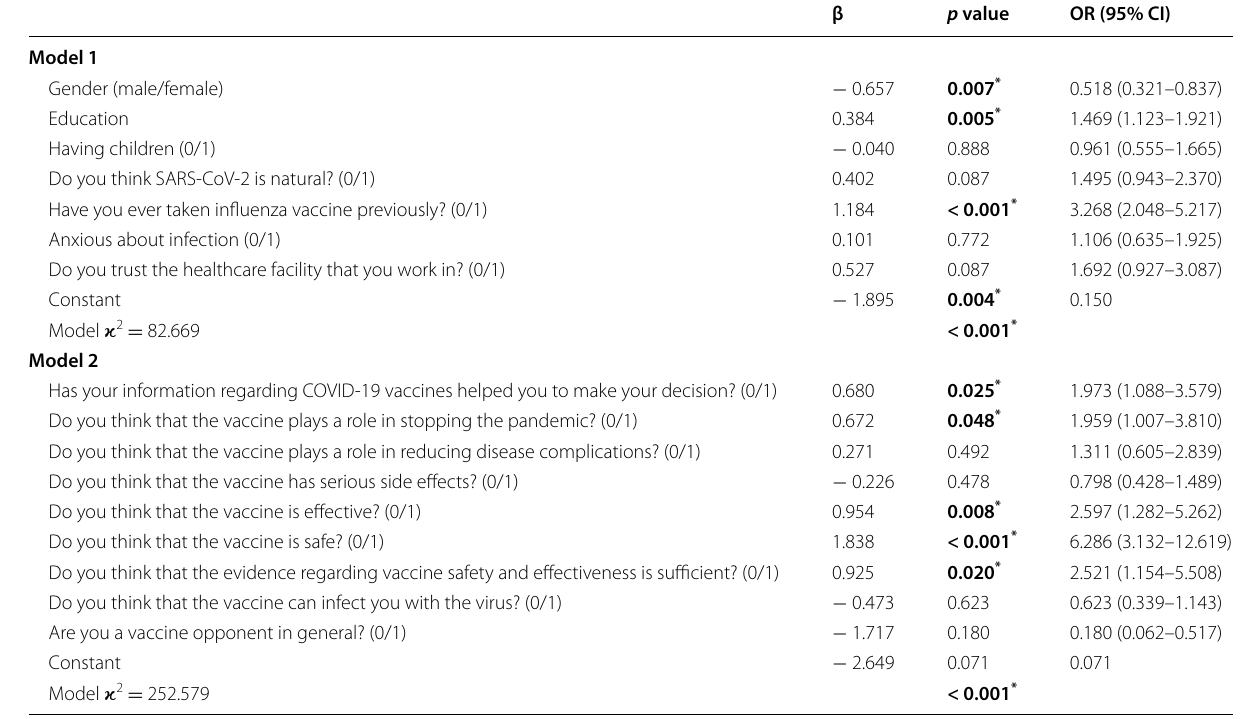
Table 2 Regression models for determinants of COVID‑19 vaccine acceptance among HCWs recruited from the participating hospitals in Ismailia, Egypt, during March and April